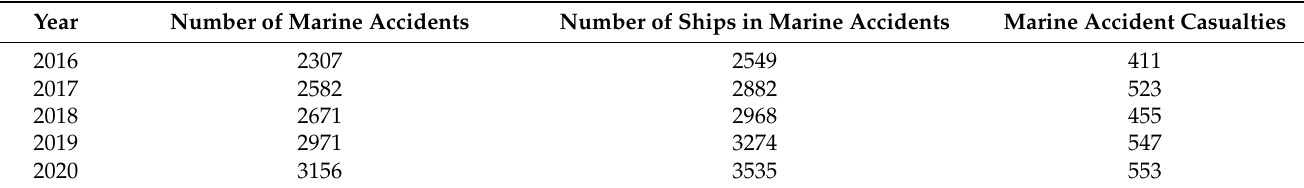
Table 1. Overall statistics of marine accidents from 2016 to